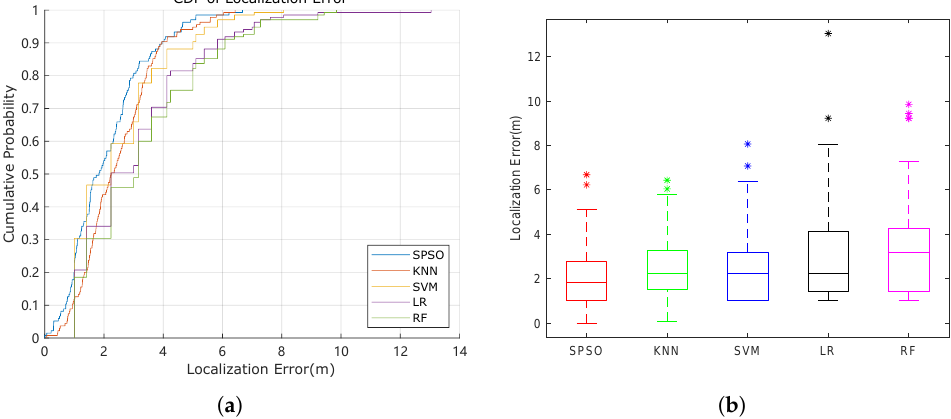
Figure 5. Distribution of the localization error. ( a ) CDF curve of the different models. ( b ) Box plot of the localization